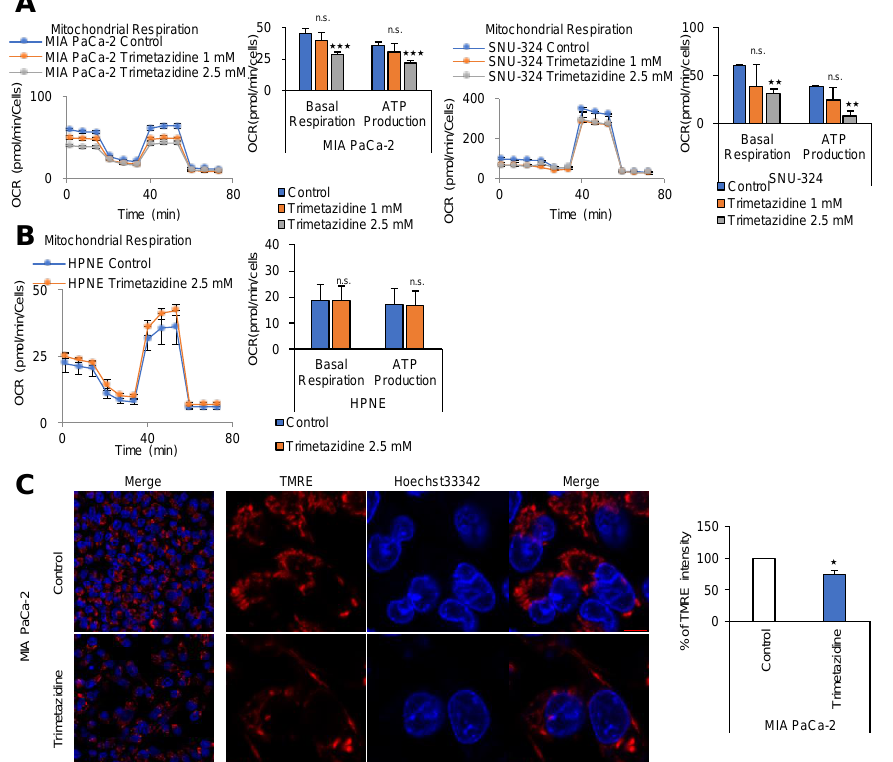
Figure 5. FAO inhibition dose-dependently decreases ATP synthesis in PDAC cells. ( A ) OCR in response to 1 mM or 2.5 mM of trimetazidine was measured using the Seahorse XFe96 analyzer in MIA PaCa-2, SNU-324, and ( B ) HPNE cells. OCR and ATP production in PDAC cells showed dose-dependent reduction while OCR and ATP production in normal cells showed no reduction. ( C ) The mitochondrial membrane potential was determined by TMRE staining and live cell imaging in MIA PaCa-2 cells treated with 2.5 mM of trimetazidine for 48 h. Scale bar = 5 µ m. * p < 0.05, ** p < 0.01, *** p < 0.001 compared with the vehicle control. n.s., not